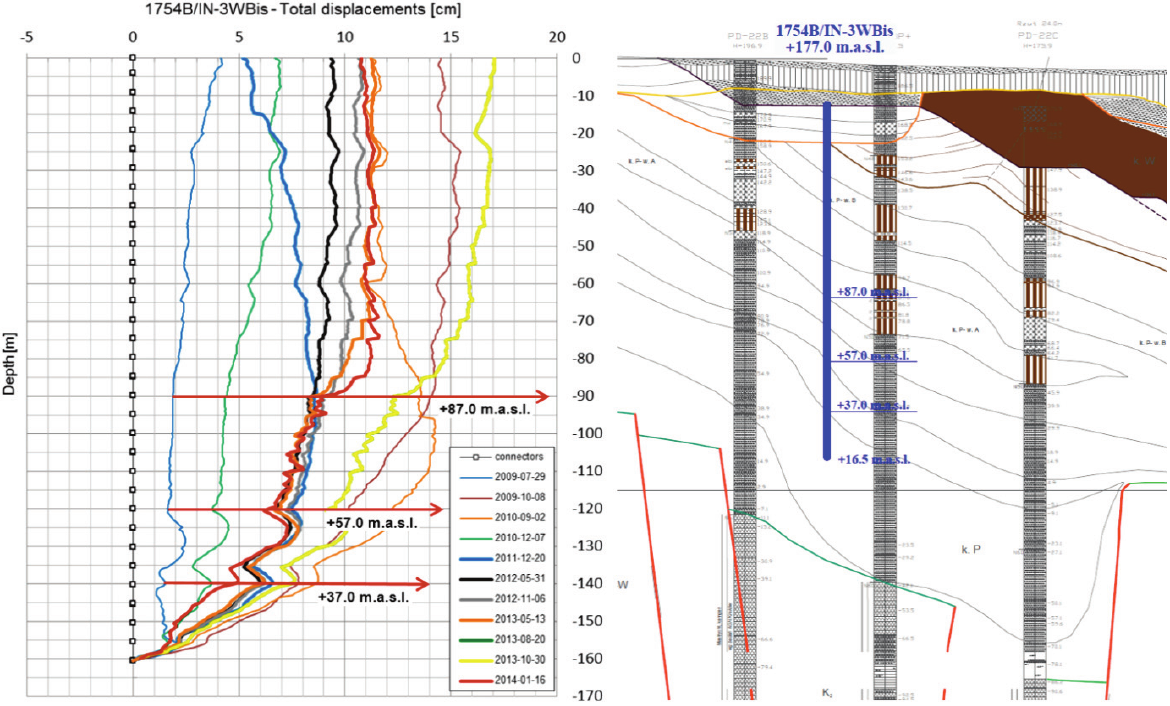
Fig. 9. The total horizontal displacements measured in inclinometer 1754B/IN-3Wbis and the geological profile with potential slip surface levels (based on [2])